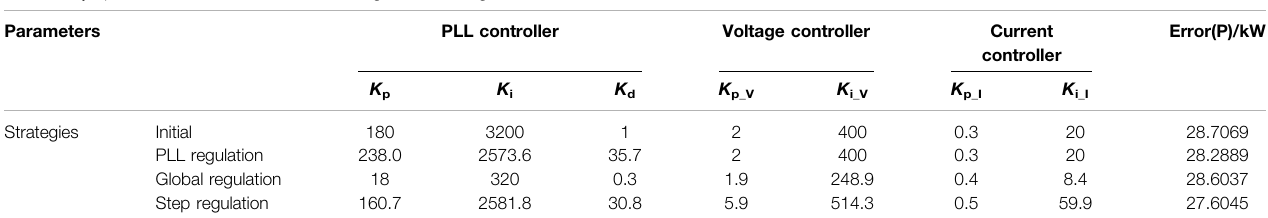
TABLE 3 | Optimization results under different regulation